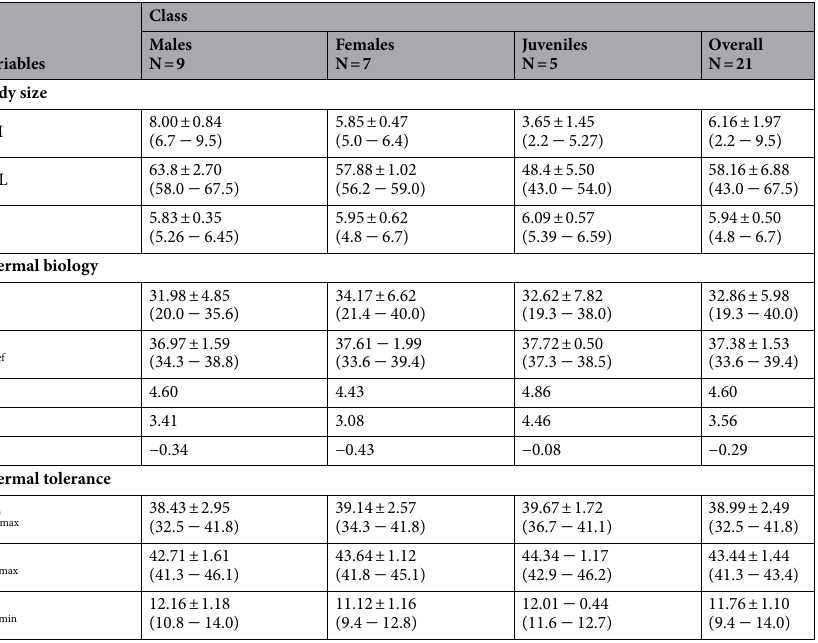
Table 1. Body size, thermal biology and thermal tolerance-related variables: Mean ± s.d. of body mass (BM, g), snout-vent length (SVL, mm), scaled mass index of body condition (M i ), body temperatures (T b , °C), preferred body temperatures (T pref , °C), absolute values obtained from the individual deviation of T b from T set (d b ), index of the average thermal quality of habitats (d e ), and index of effectiveness of thermoregulation (E), voluntary